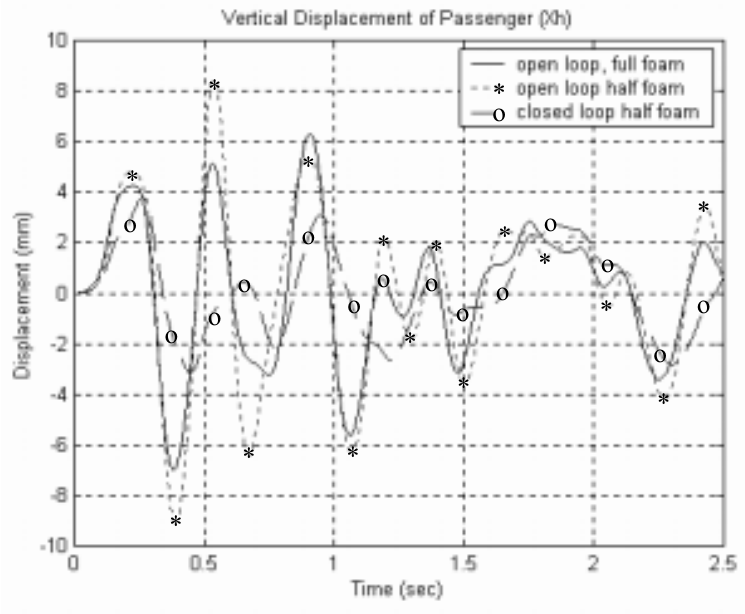
Fig. 4. Simulated time history for passive and active